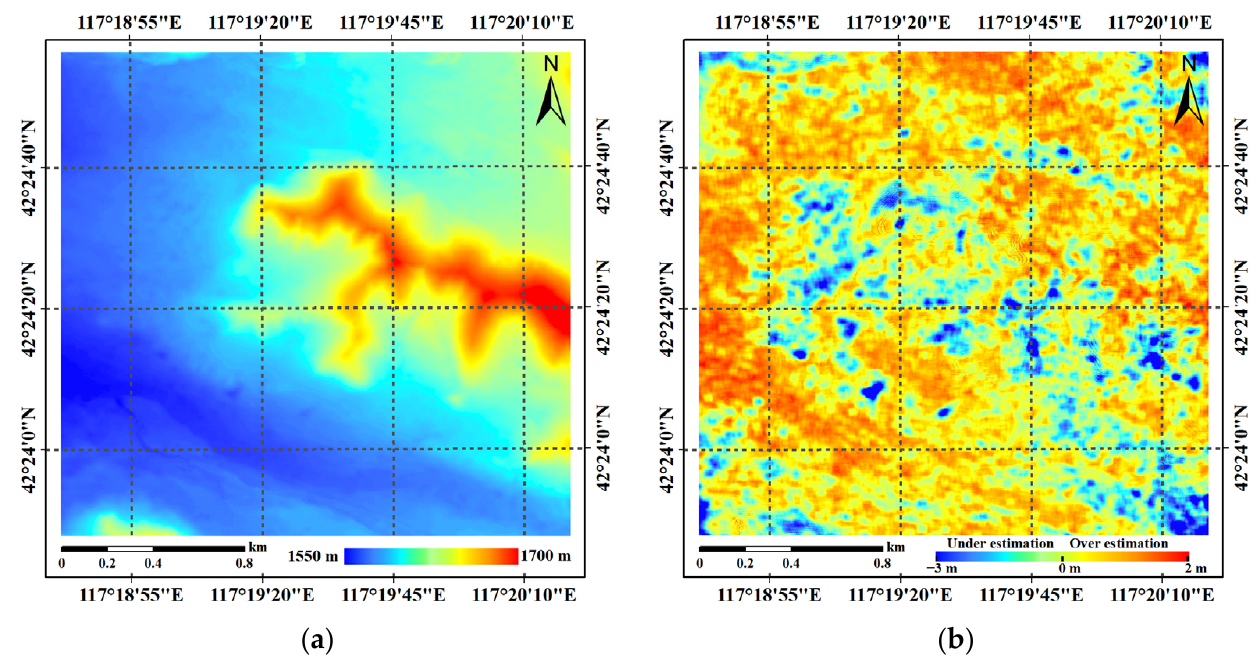
Figure 8. The DTM extracted result and deviation based on P-band InSAR: ( a ) DTM P-band ; ( b ) Differ- ence between DTM P-band and DTM LiDAR .